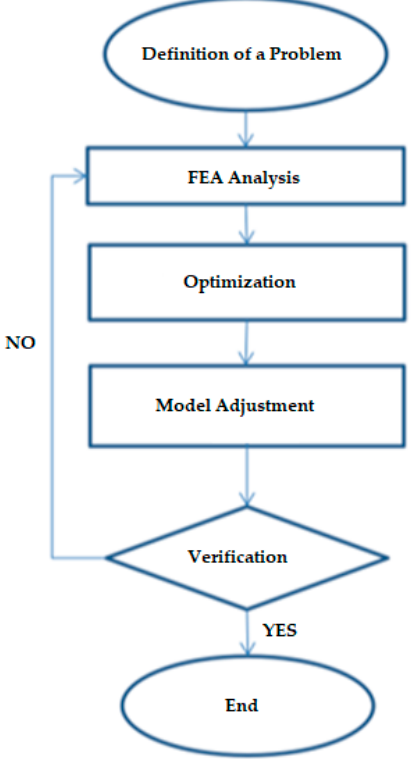
Figure 3. Flow diagram of the process of optimization of topology .